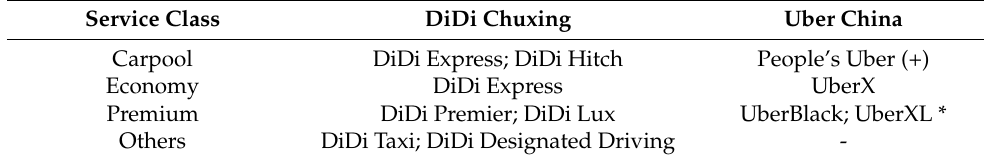
Table 2. Service classes and offerings from DiDi and Uber. Service